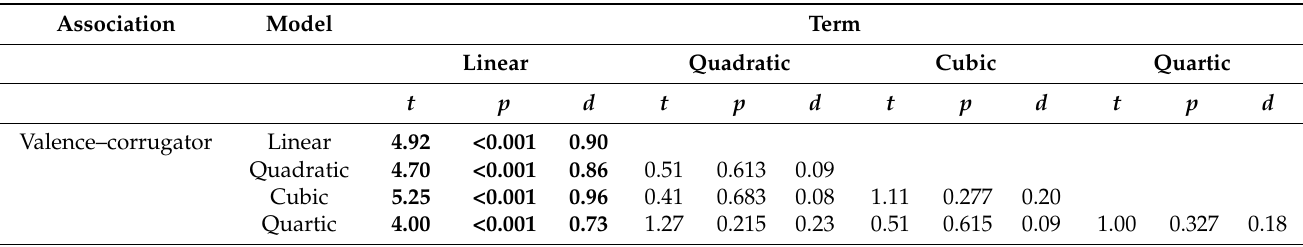
Table 3. Results of one-sample t -test (two-tailed) for the parameter estimates in polynomial regression modeling of subjective–physiological